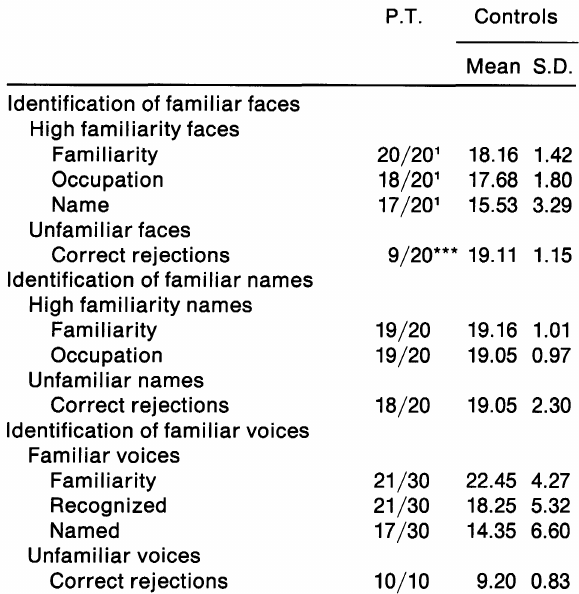
Identification of familiar